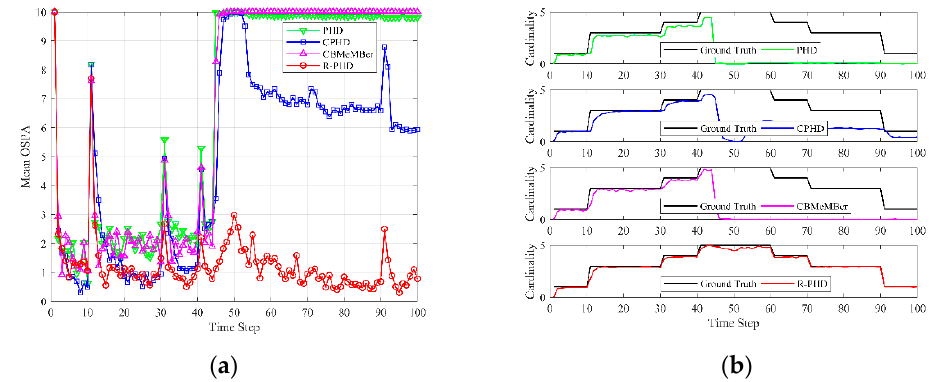
Figure 7. OSPA and cardinality performances of di ff erent methods versus time under continuous miss detection during 45 ≤ k ≤ 51 ( p D = 0.9, λ = 10): ( a ) mean OSPA; ( b ) mean